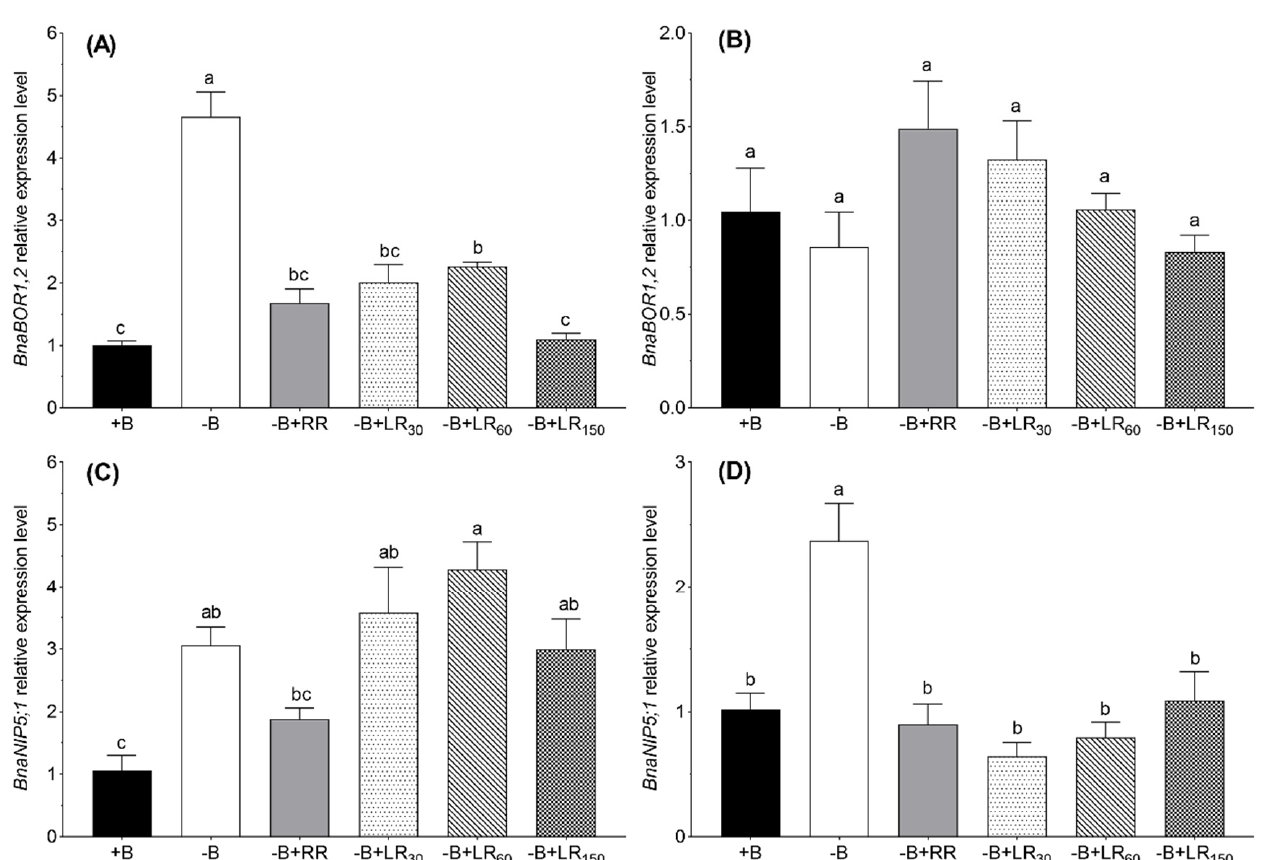
Figure 6. The fold change in the relative expression of BnaBOR1;2 and BnaNIP5;1 gene in roots ( A , C ) and leaves ( B , D ) of Brassica napus grown in nutrient solution under different B treatments for 42 days. +B, 25 µM B in NS; − B, 0.25 µM B in NS; − B+RR, 0.25 µM B in NS for the first two weeks and then 25 µM B for the latter two weeks; − B+LR 30 , 0.25 µM B in NS and foliar-applied 30 mM B at two weeks; − B+LR 60 , 0.25 µM B in NS and foliar-applied 60 mM B at two weeks; − B+LR 150 , 0.25 µM B in NS and foliar-applied 150 mM B at two weeks. Bars represent means of three biological replicates, technically replicated two times ± SE. Different letters on bars indicate significant differences be- tween treatments (ANOVA with Duncan’s multiple range test p ≤ 0.05).